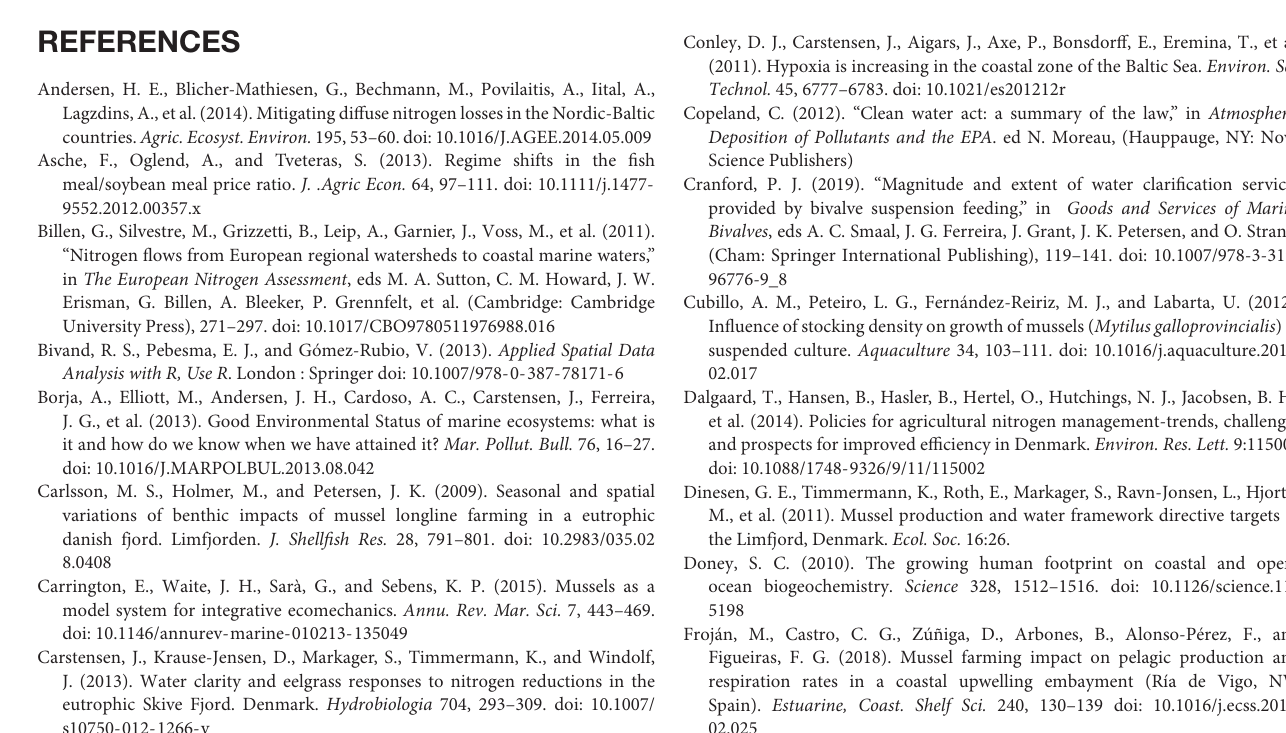
Figueiras, F. G. (2018). Mussel farming impact on pelagic production and respiration rates in a coastal upwelling embayment (Ría de Vigo, NW Spain). Estuarine, Coast. Shelf Sci. 240, 130–139 doi: 10.1016/j.ecss.2018.